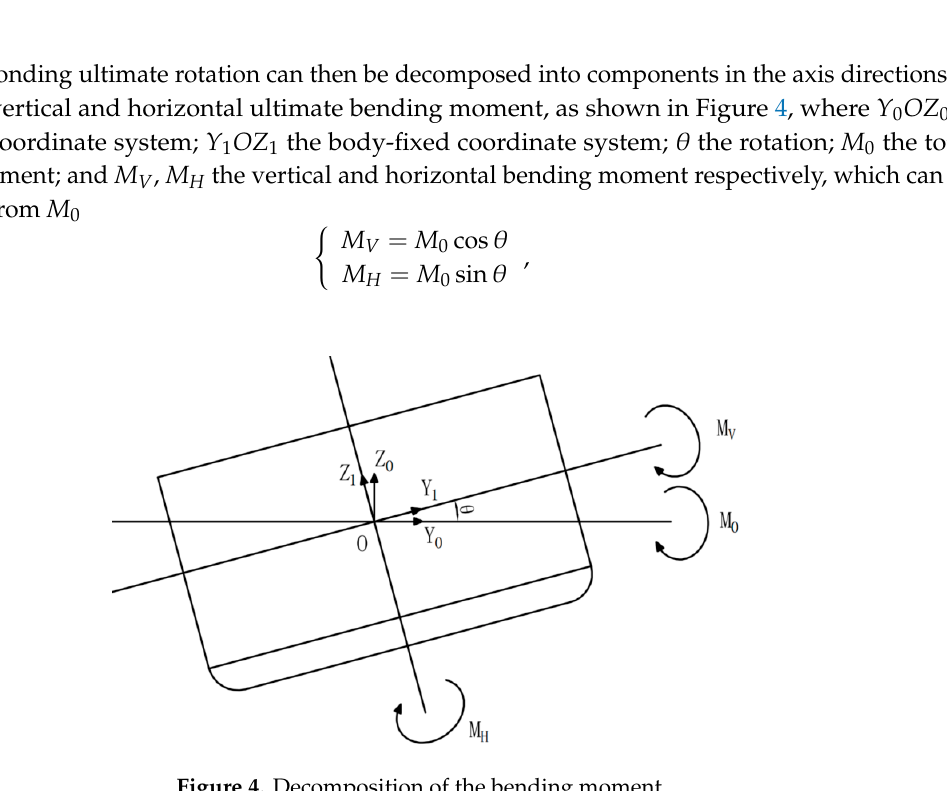
Figure 4. Decomposition of the bending moment.